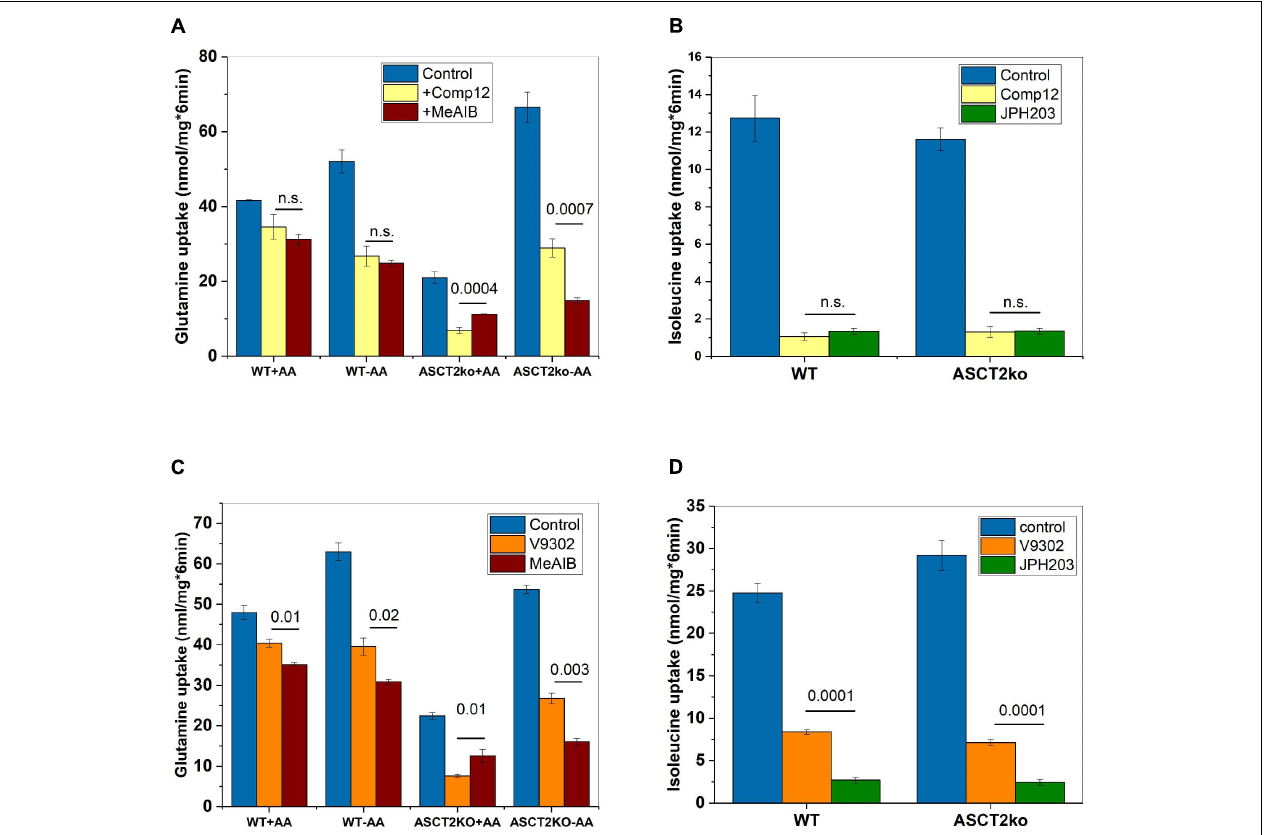
FIGURE 3 | Inhibition of system A and LAT1 activity by AABA. (A) Uptake of [ 14 C]glutamine (100 µ M) was measured in parental (wt) or ASCT2ko 143B cells in the presence ( n = 9 each group) or absence of 100 µ M compound 12 ( n = 9 each group) or 10-mM MeAIB ( n = 6). Before transport, cells were kept in DMEM/F12 medium supplemented with 10% FCS (+AA) or in Hank’s buffered salts solution plus 5-mM glucose and 1% dialyzed FCS (–AA) for 12 h. n.s. difference not significant. p -Values for significant differences are shown in the figure. (B) Uptake of [ 14 C]isoleucine (100 µ M) was measured in Na + -free buffer in 143B cells ( n = 6), in the presence ( n = 6) or absence ( n = 6) of 100 µ M compound 12 or 2 µ M JPH203 ( n = 6) n.s. difference not significant. (C) Uptake of [ 14 C]glutamine was measured as in A , but V-9302 was used instead of compound 12 ( n = 3, p -values indicated in the figure). (D) Uptake of [ 14 C]isoleucine was measured as in B , but V-9302 was used instead of compound 12 ( n = 3, p -values indicated in the figure).